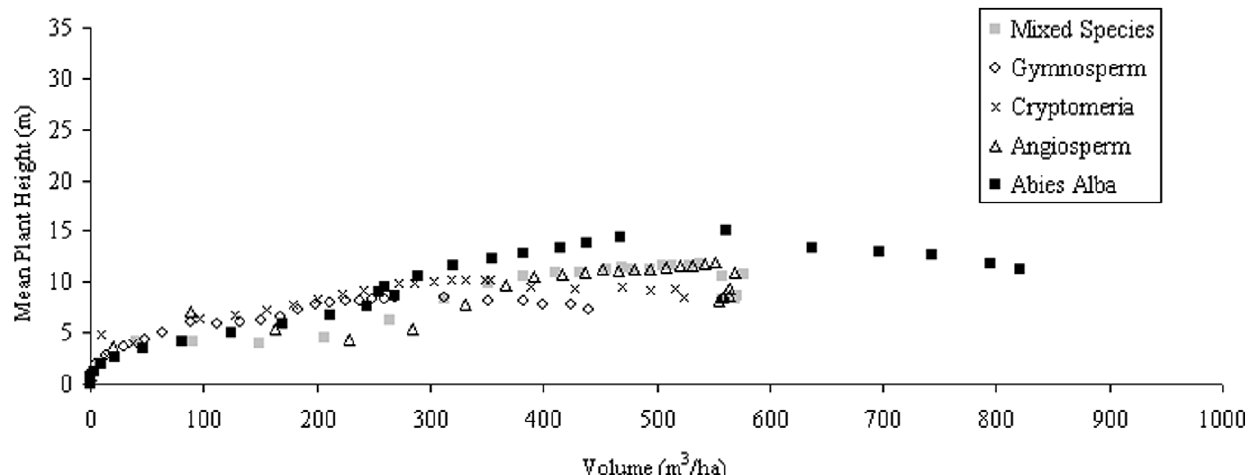
Figure 6. H mean against forest volume for planting densities of 10000 ha 2 1 .